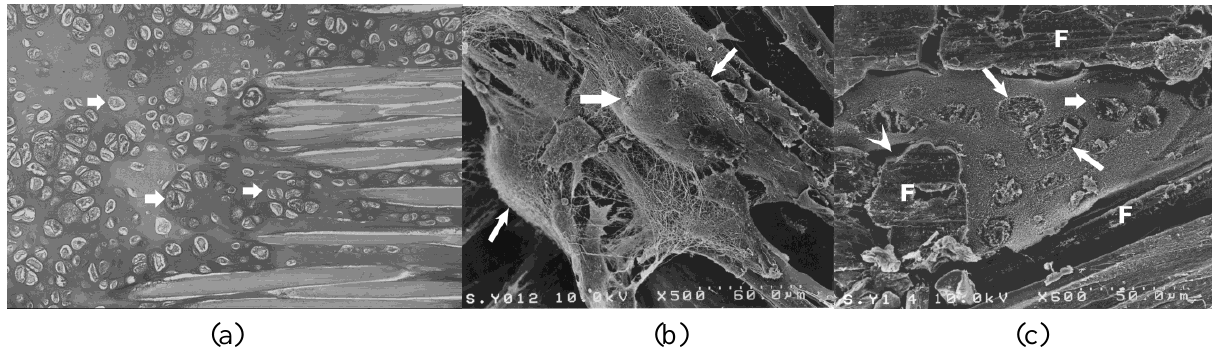
Figure 3. Light microscopy and SEM images of chondrocytes seeded on the hybrid polymer fibers at 14 days after cultivation. The light micrograph shows the proliferation of chondrocytes seeded on the hybrid polymer fibers ( a ) The SEM images demonstrate the characteristic round morphology of the chondrocytes ( b ) and the dense fibers of the type II collagen around the chondrocytes ( c ) White arrows indicate chondrocytes. F, hybrid polymer fibers [16].